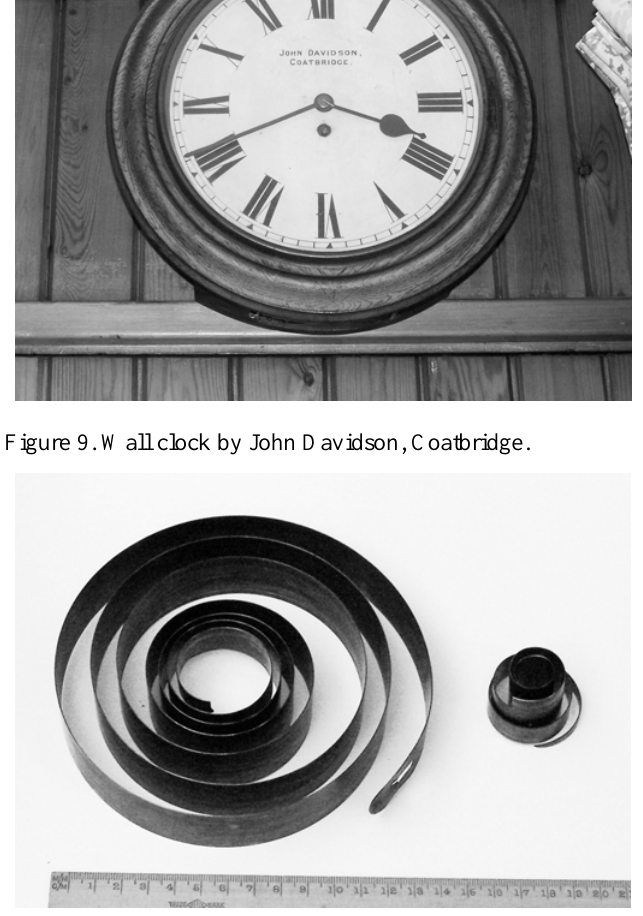
Figure 10. Failed wall clock mainspring.